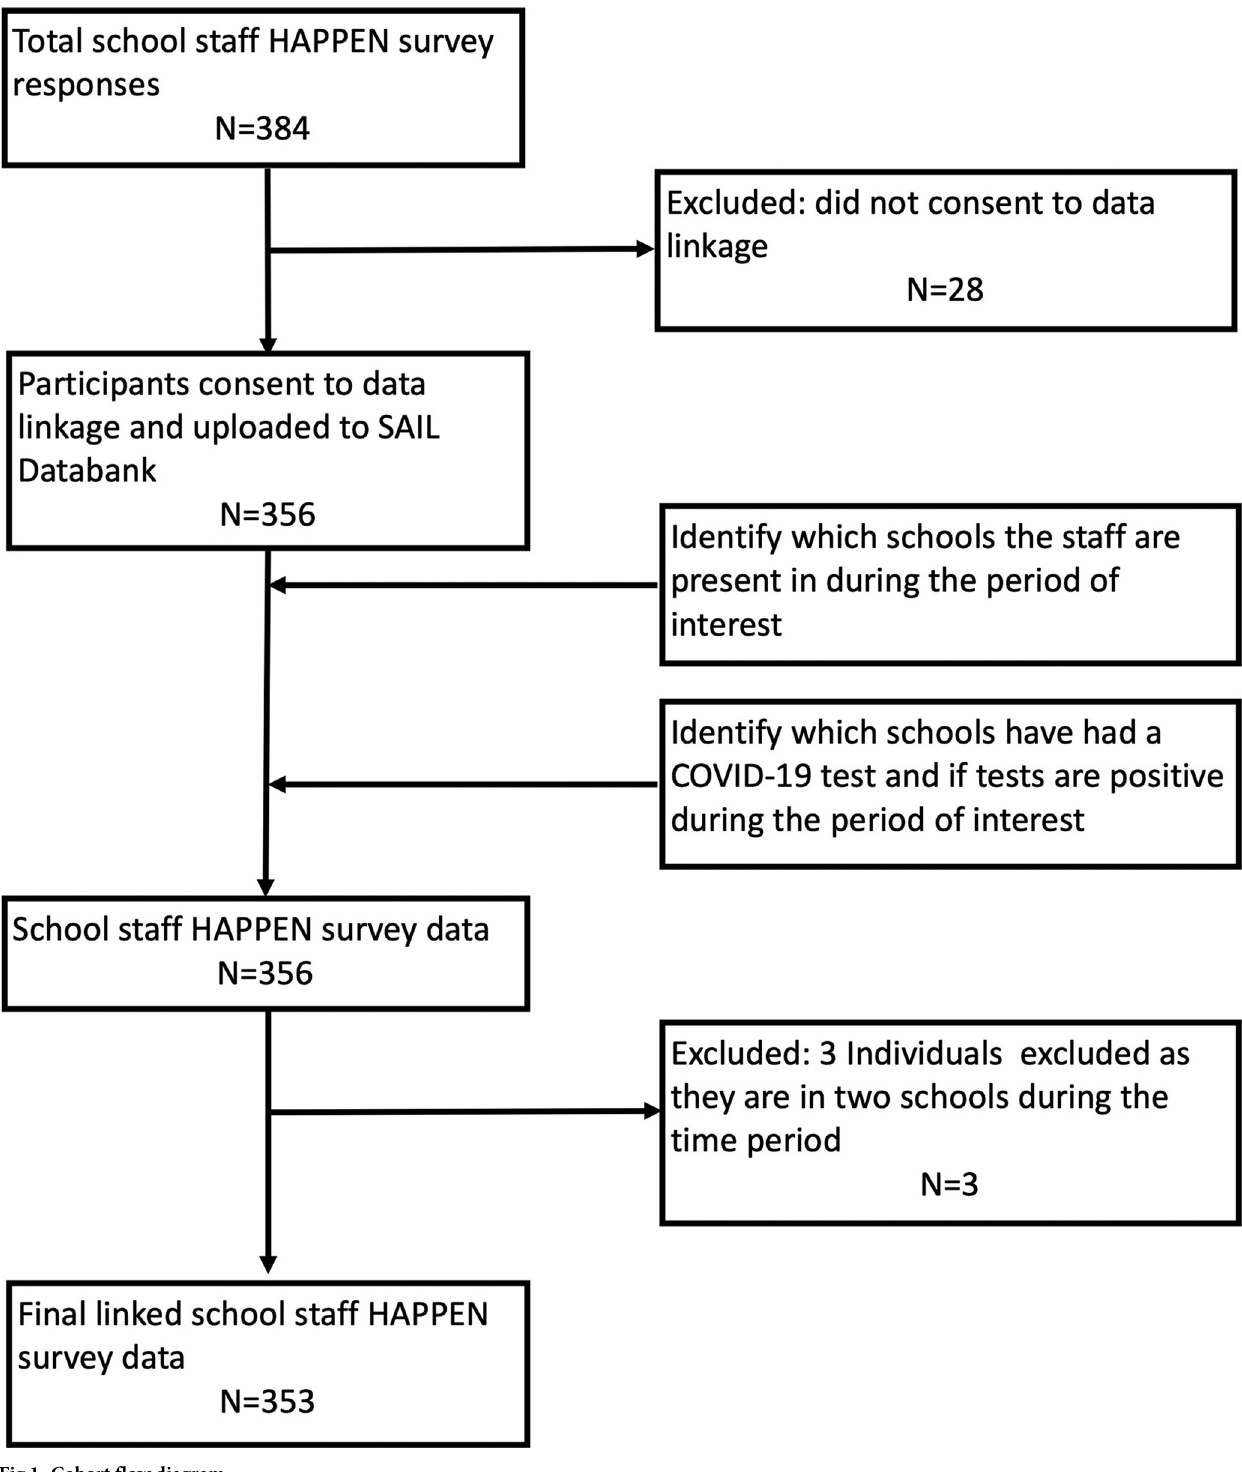
Fig 1. Cohort flow